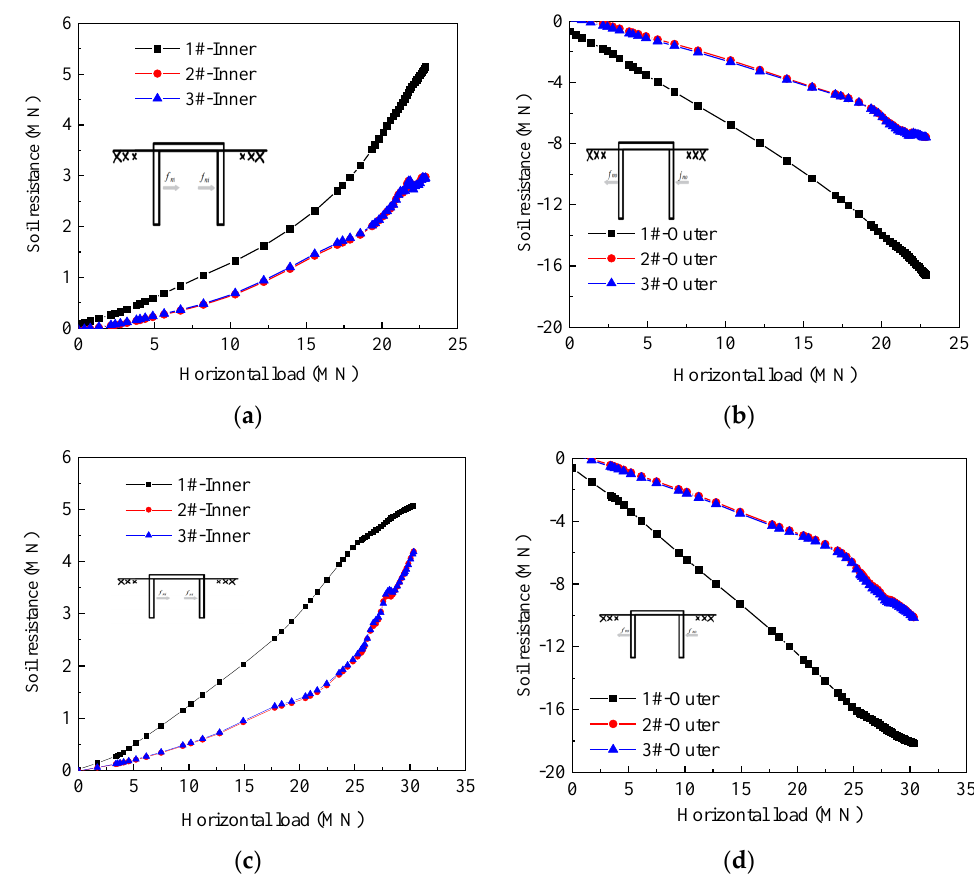
Figure 14. Lateral soil resistance on the skirt wall of the TSPJF and TBJF at the different horizontal loads. ( a ) soil resistance on the inside skirt wall of the TSPJF, ( b ) soil resistance on the outside skirt wall of the TSPJF, ( c ) soil resistance on the inside the skirt wall of the TBJF, ( d ) soil resistance on the outside the skirt wall of the TBJF.